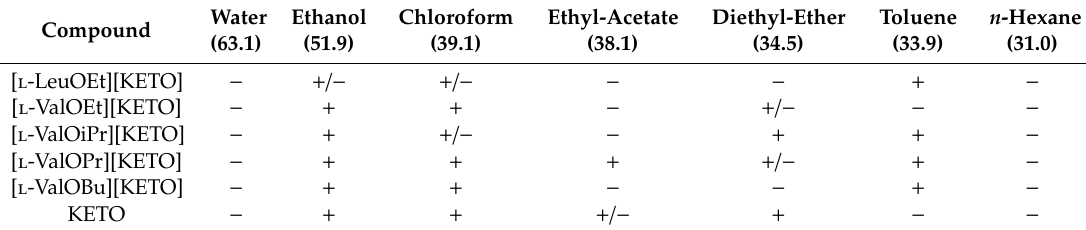
Table 2. Solubility in water and organic solvents of ketoprofen and its amino acids derivatives at 25 ◦ C. Compound